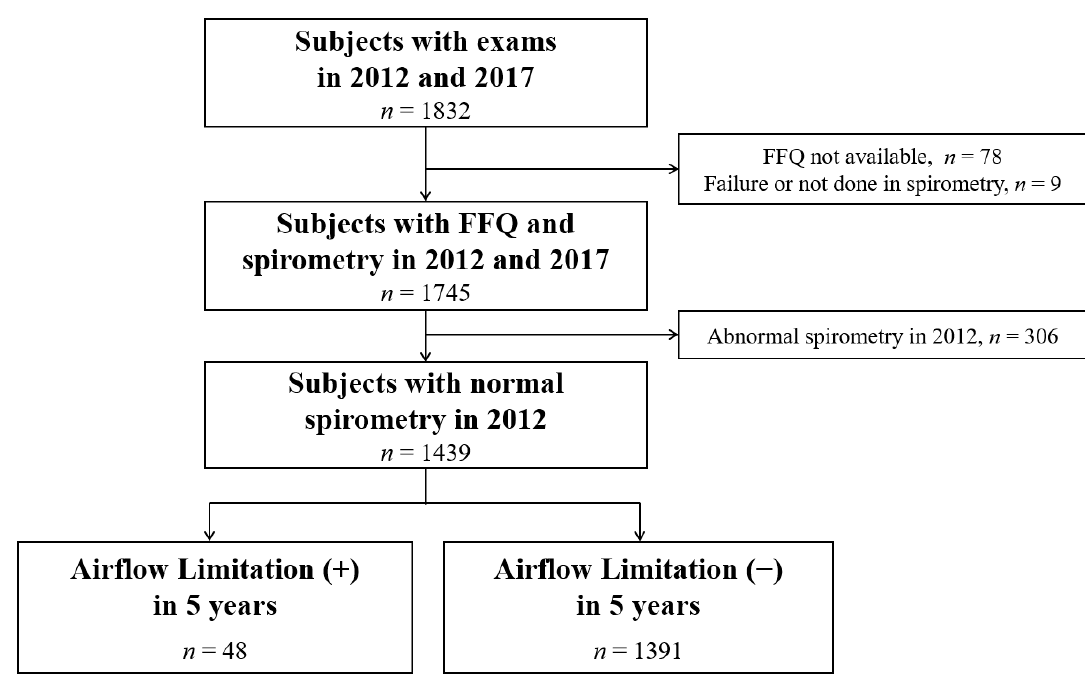
Figure 1. Flow diagram of the study population. A total of 1439 examined subjects with normal spirometry at baseline were enrolled among which 48 (3.3%) had developed a new airflow limitation after 5 years. FFQ, Food Frequency Ques- tionnaire.